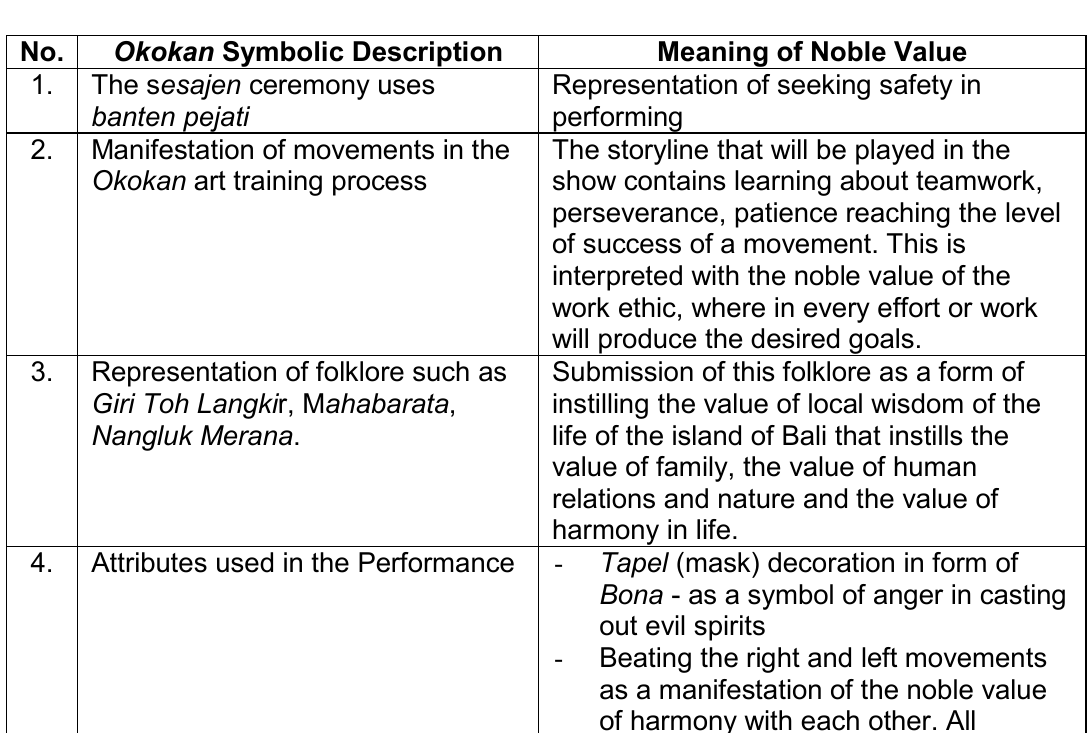
Table 2. The Symbolic Interactionalism of the Symbolization of The Noble Values of The Traditional Art of